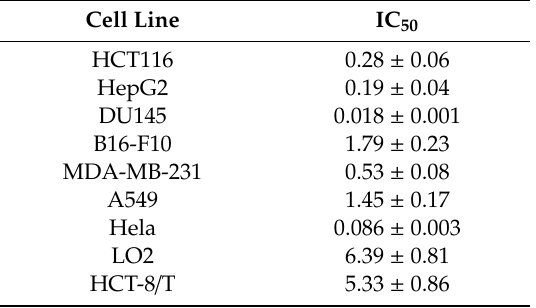
Table 20. IC 50 (in µ M) values of 81 against human colon carcinoma cells HCT116, human hepatocellular liver carcinoma cells HepG2, prostate DU145, skin B16-F10, breast MDA-MB-231, and A549 and the cervical Hela cancer cell lines, along with the normal LO2 cell line and the drug-resistant HCT-8 / T .